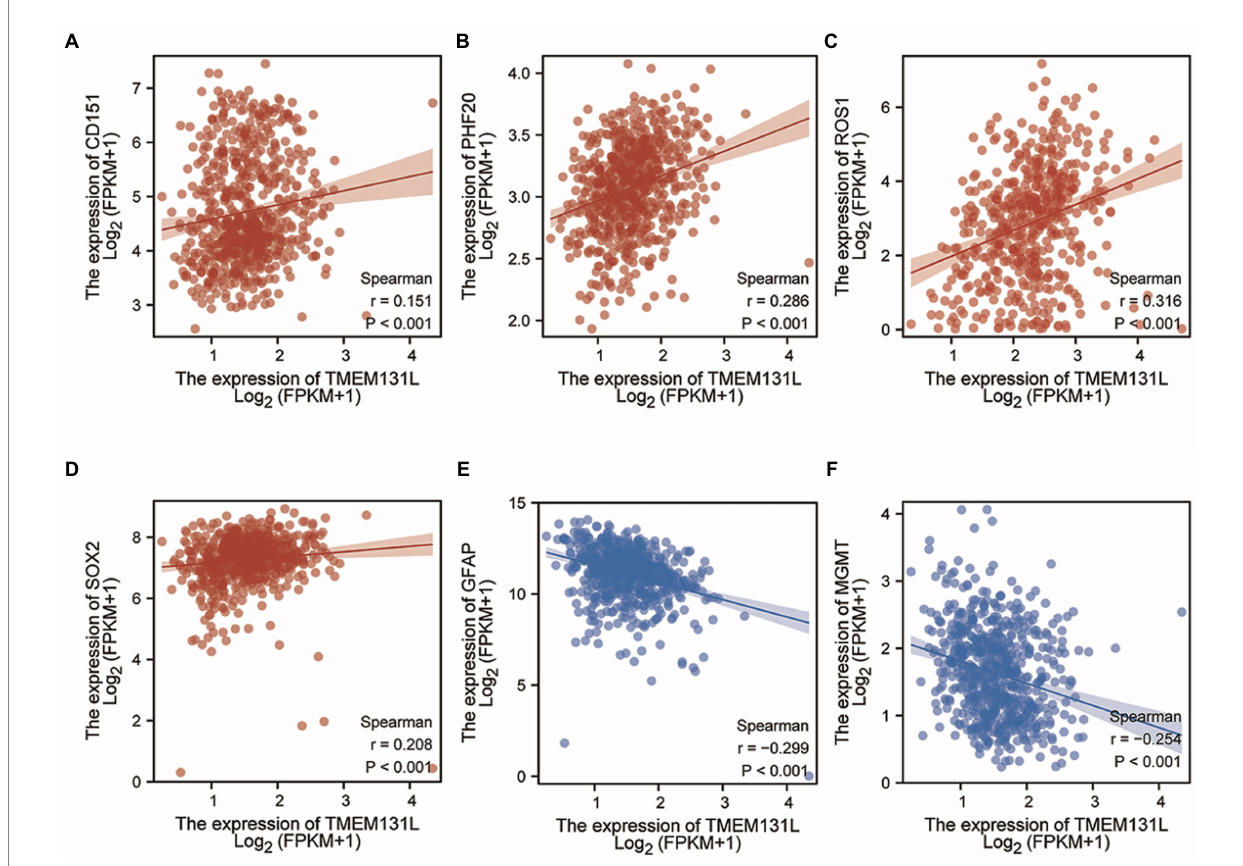
FIGURE 3 Correlation between TMEM131L and molecular markers of GBM and oxidative stress. (A–D) TMEM131L was positively correlated with the expressions of CD151, PHF20, ROS1, and SOX2, respectively. (E, F) TMEM131L was negatively correlated with GFAP and MGMT expression,